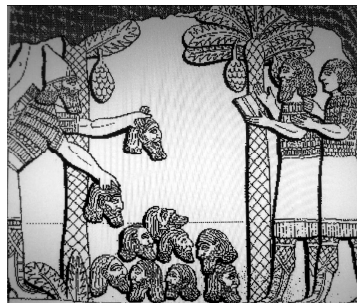
Figure 5. Counting the heads of the fallen warriors.